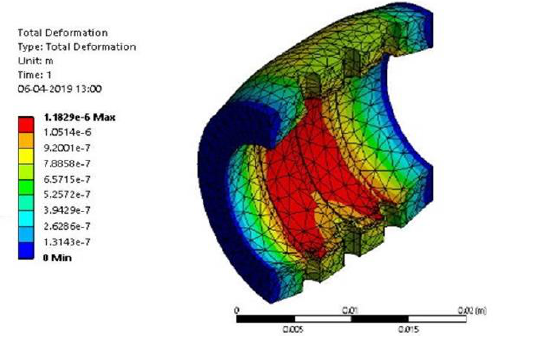
Fig. 14. Deformed bearing 1 under pressure from oil film